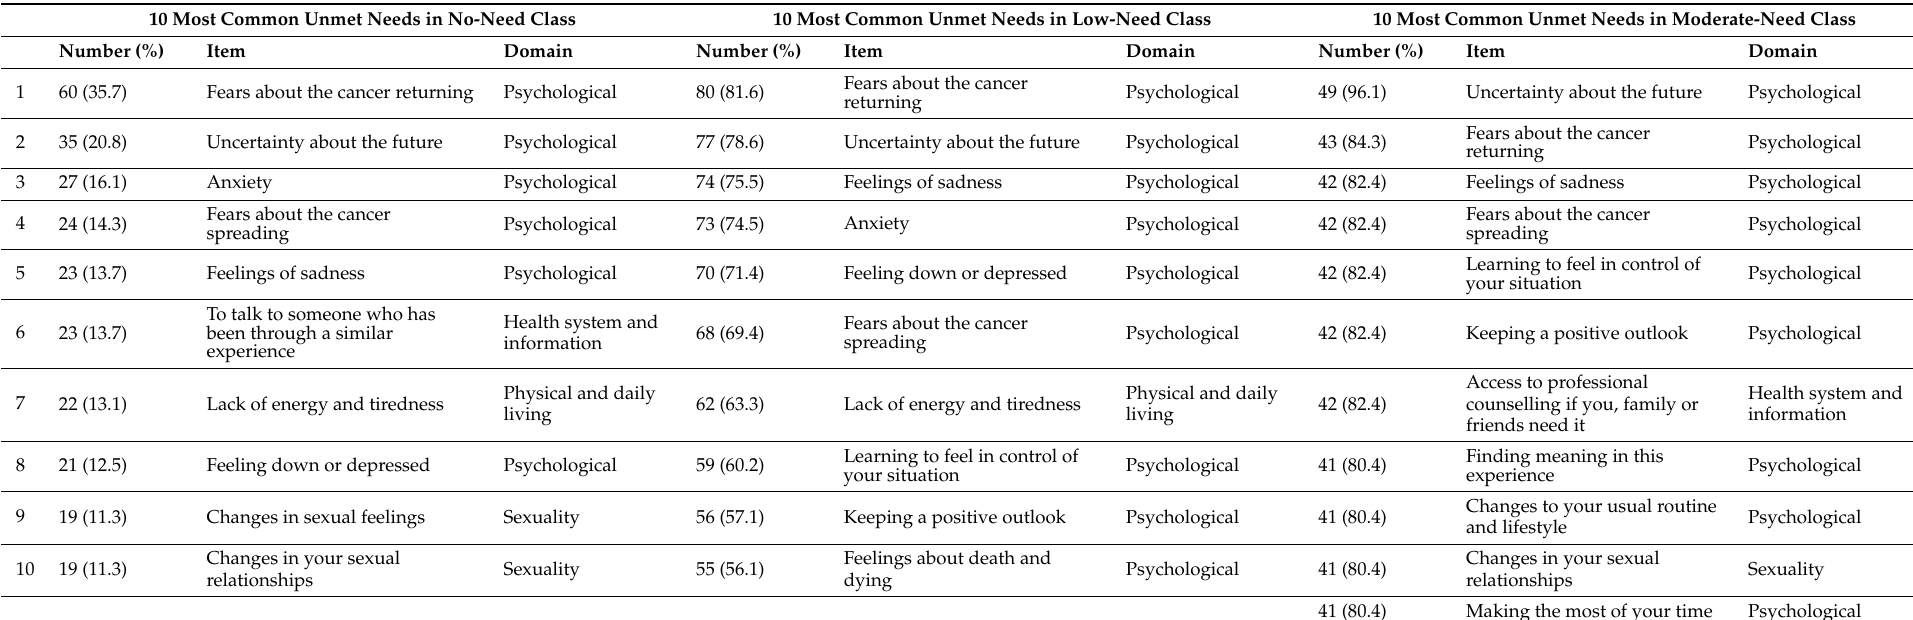
Table 3. Ten most common unmet supportive care needs stratified by level of supportive care